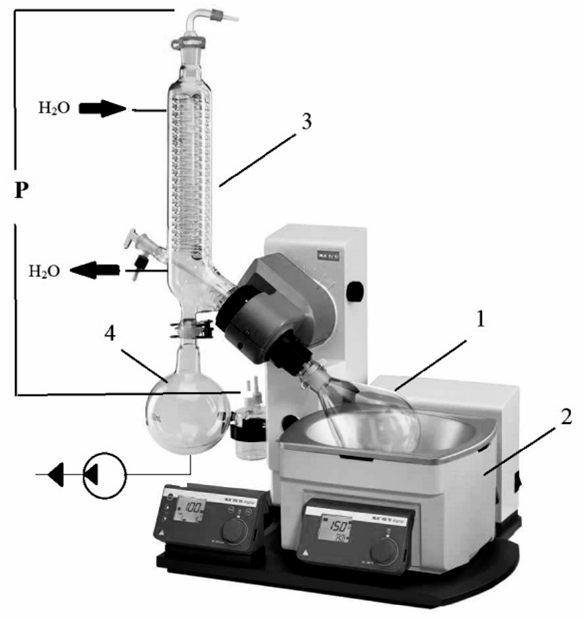
Figure 2. Scheme of the rotary evaporator IKA-RV 10 digital: 1—evaporator cube, 2—oil bath, 3—refrigerator, 4—receiving flask.